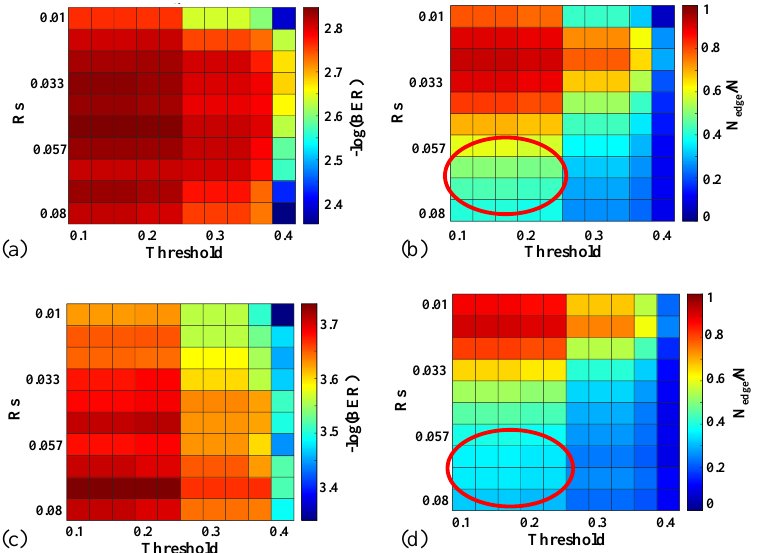
ranges are coincident with that at the data rate of 1.6 Gbps.